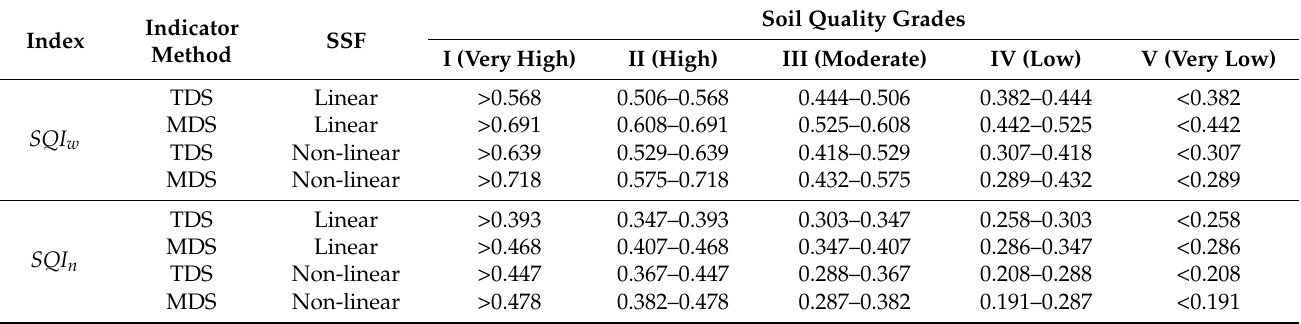
Table 6. Soil quality grades classification for indices and indicator methods.